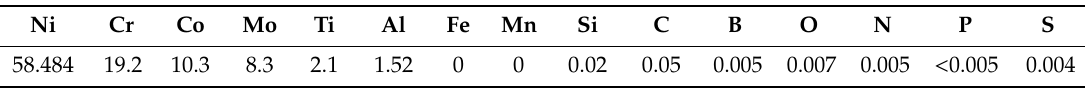
Table 2. Table showing the composition in weight percentage of the Haynes-282 powder as-received from the manufacturer.